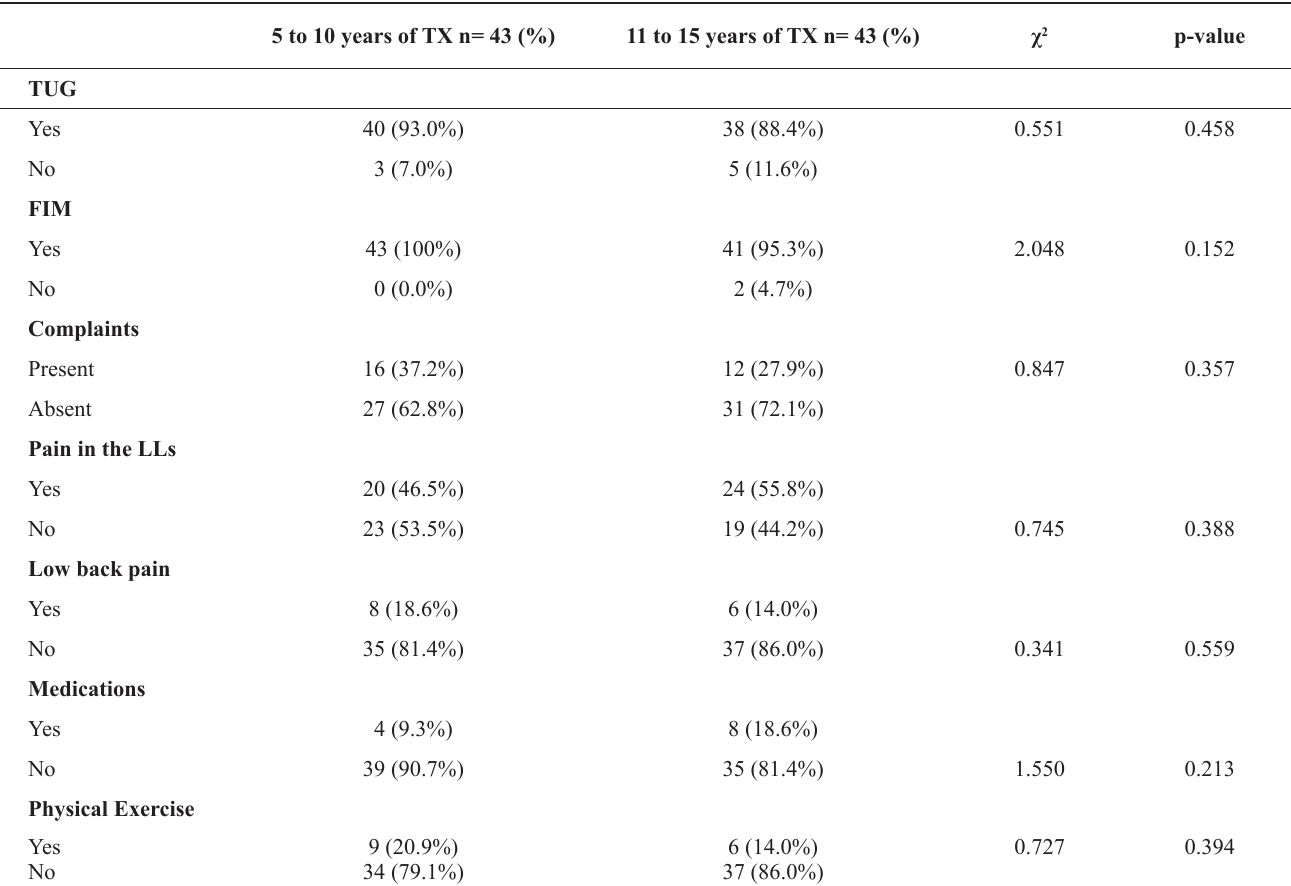
Table 3. Characteristics of individuals in the study related to the time of kidney transplantation. 5 to 10 years of TX n= 43